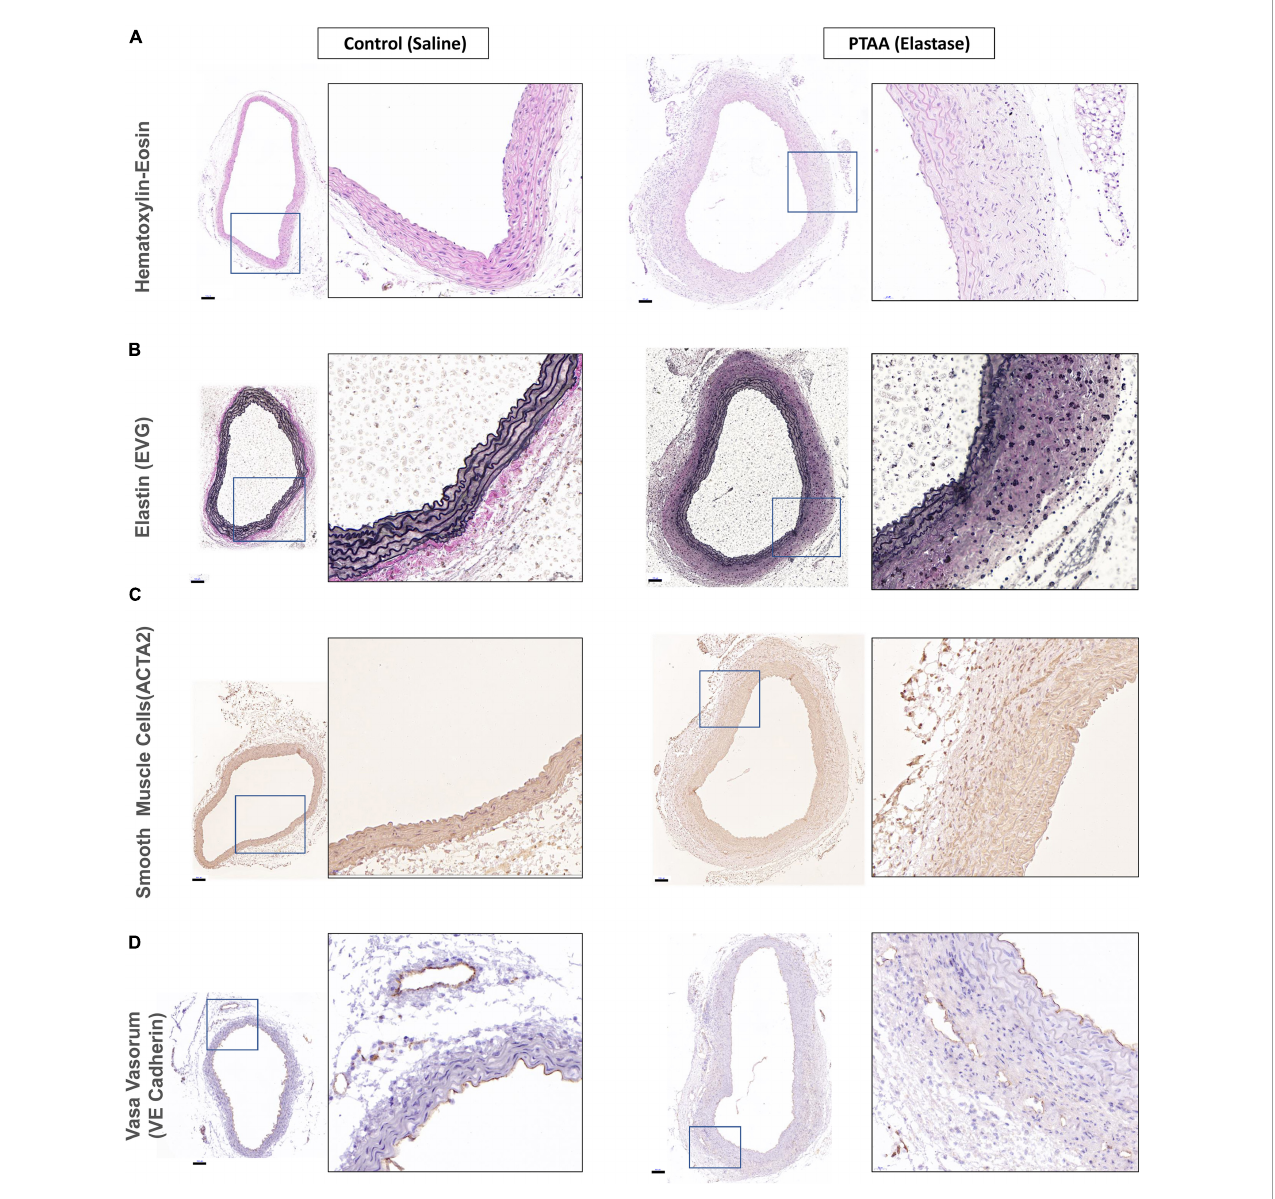
FIGURE3 Histopathological examination of ascending aorta in control (saline) and proximal thoracic aortic aneurysm (PTAA) (Elastase). (A) Representative images of hematoxylin-eosin staining in both groups. (B) Representative images of elastin (EVG) staining in both groups. (C) Representative images of ACTA2 immunohistochemical staining (smooth muscle cells) in both groups. (D) Representative images of VE-Cadherin immunohistochemical staining (vasa vasorum) in both groups. Scale bar in the left figure showed is 100 µ m, the magnification of the local enlarged view on the right is